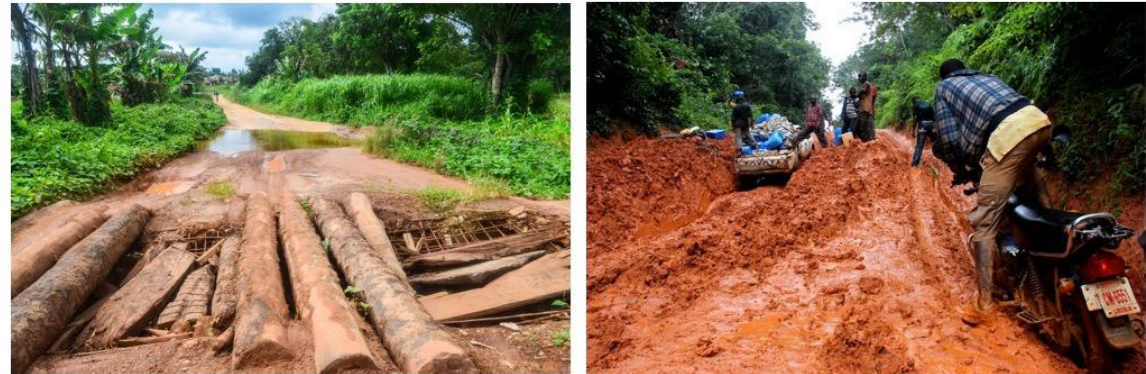
Figure 2. Rural bridges and roads in Sierra Leone and Liberia, 2013. Left-hand photograph by J. B. Dodane, right-hand photograph by Travis Lupik, both used with